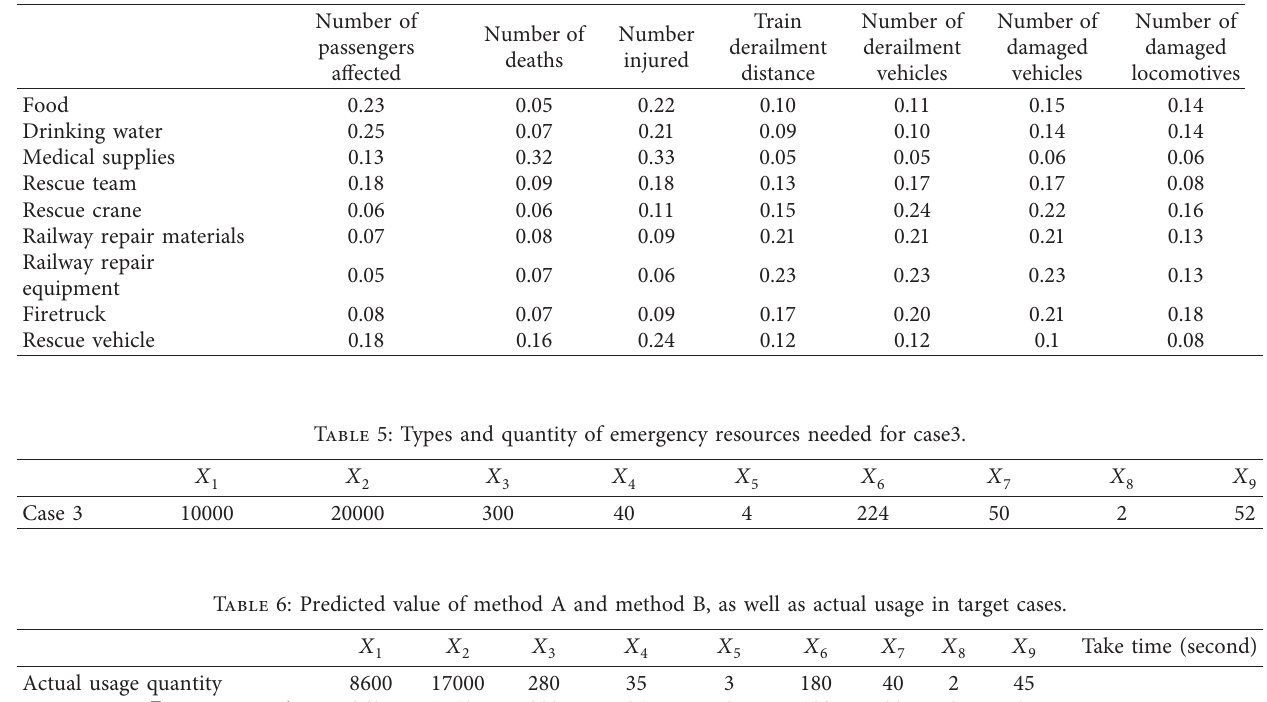
Table 4: Attribute weight coefficient table for emergency resources.